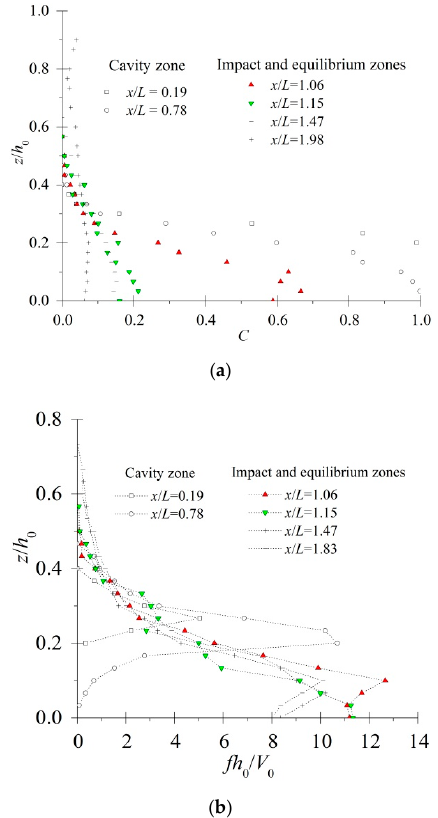
Figure 2. Distributions of air concentration ( a ) and bubble frequency ( b ) along the chute (S5: V 0 = 9 m/s, F 0 = 7.4).